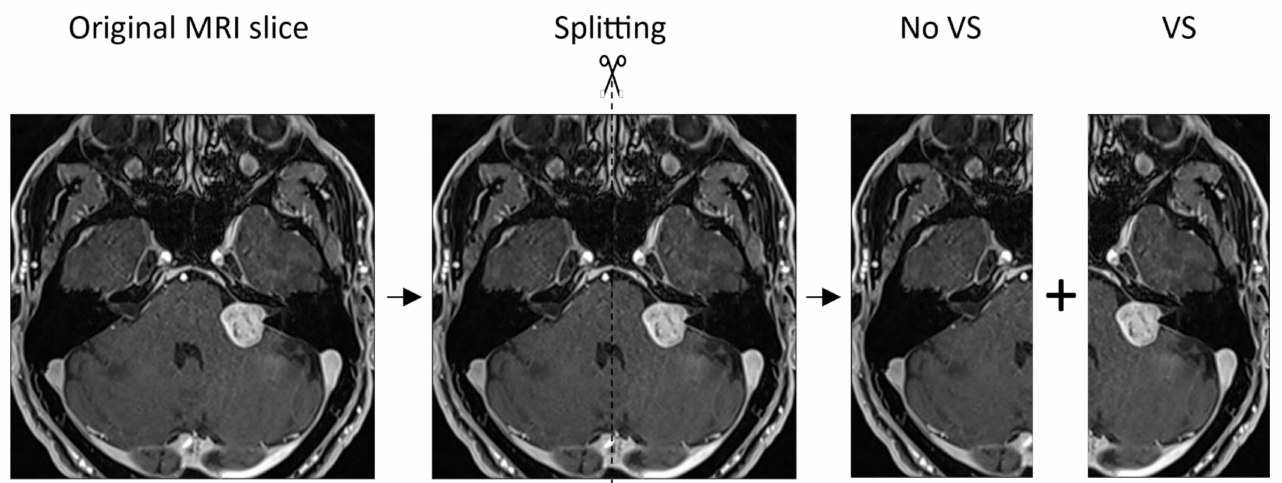
Figure 2. Workflow of splitting the magnetic resonance imaging (MRI) slices into a left and right image, resulting in a hemisphere with and without a